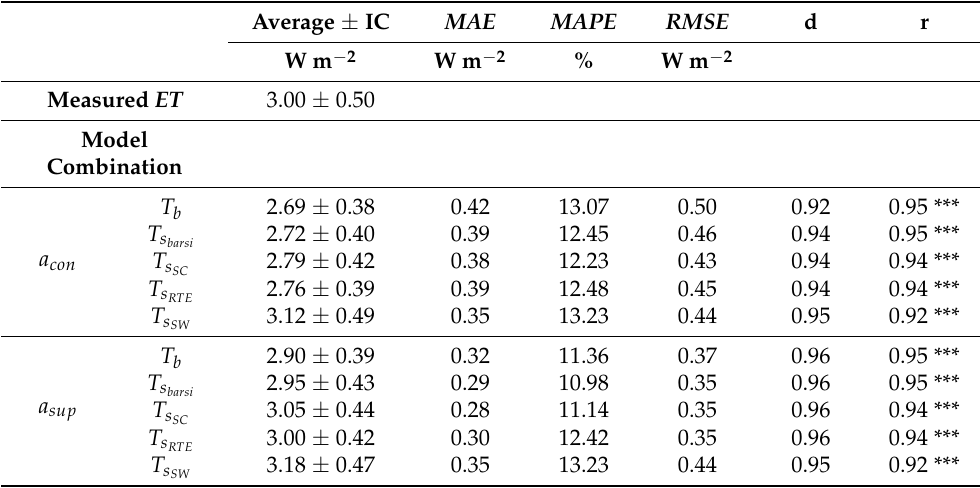
Table 10. Average ( ± 95% confidence interval) of the measured evapotranspiration ( ET ; mm d − 1 ) in the flux towers, and the average ( ± 95% confidence interval), mean absolute error ( MAE ), mean absolute percent error ( MAPE ), root mean square error ( RMSE ), Willmott coefficient (d), and Pearson correlation coefficient (r) of the estimated soil heat flux using the conventional ( a con ) and parameter- ized ( a sup ) surface albedo models combined with brightness temperature ( T b ) and surface temperature corrected by the Barsi model ( T s ), the single-channel model ( T s ), the radiative transfer equation SC barsi model ( T s ), and the split-window model ( T s ). Values with (***) indicate p -value < 0.001. RTE SW Average ±